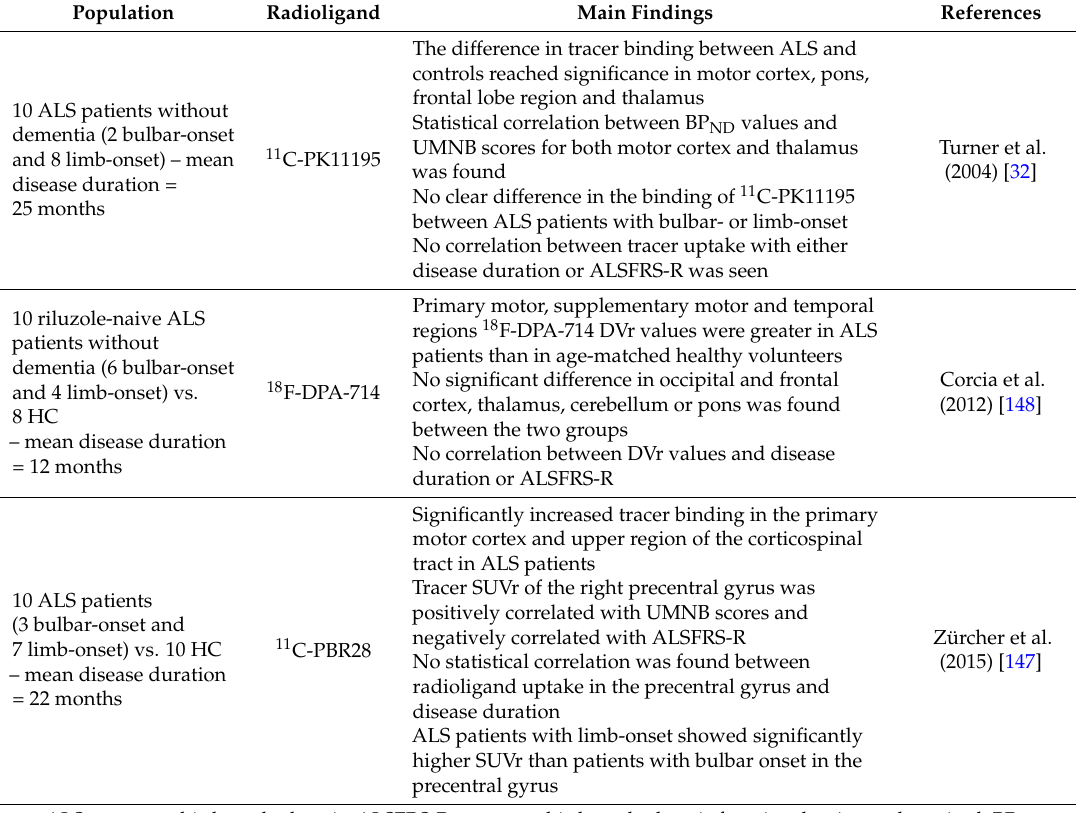
Table 5. PET imaging studies assessing TSPO tracers in amyotrophic lateral